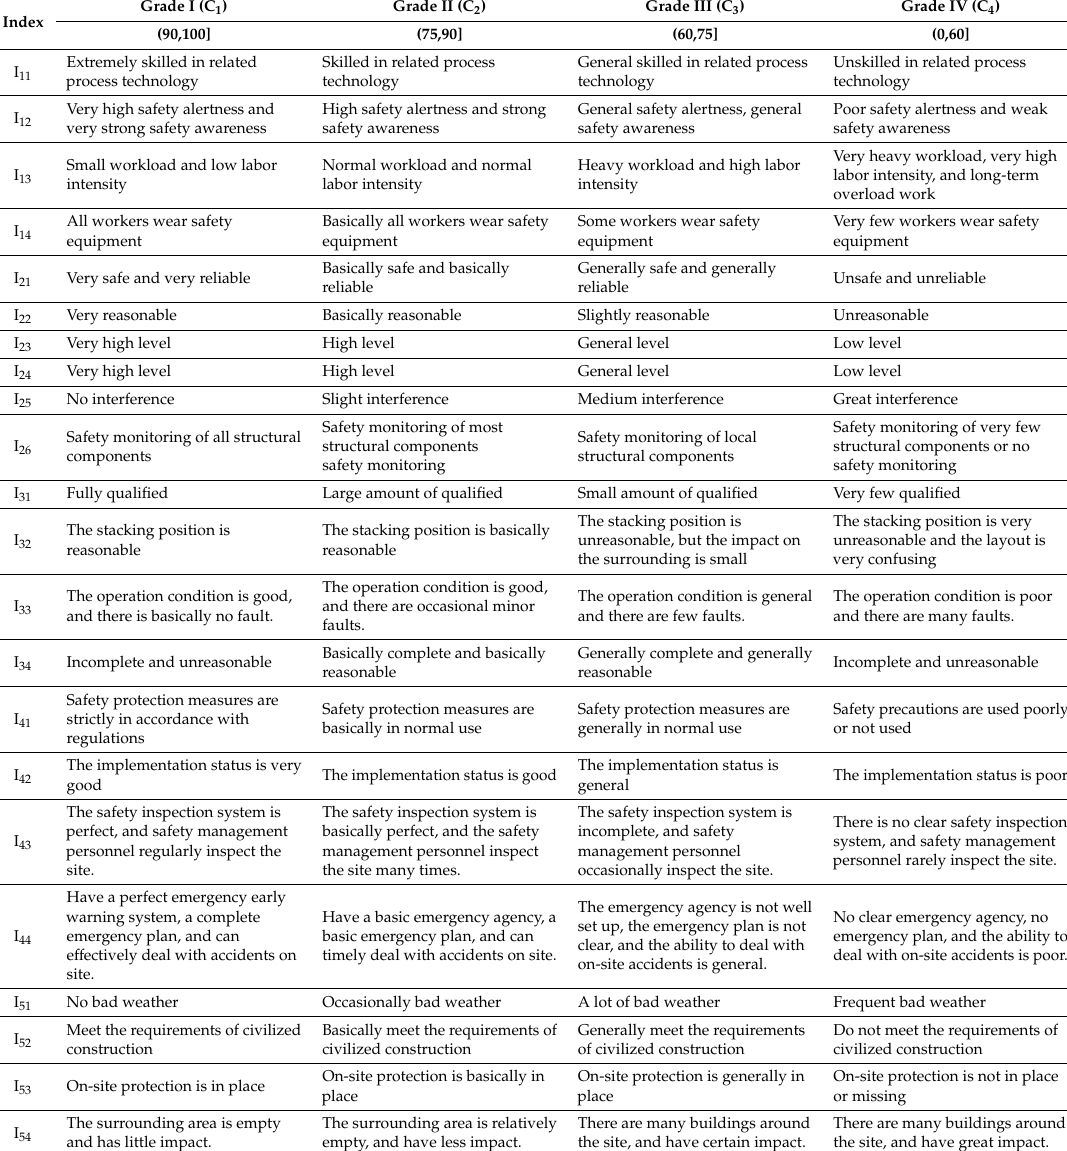
Table 2. The index grading